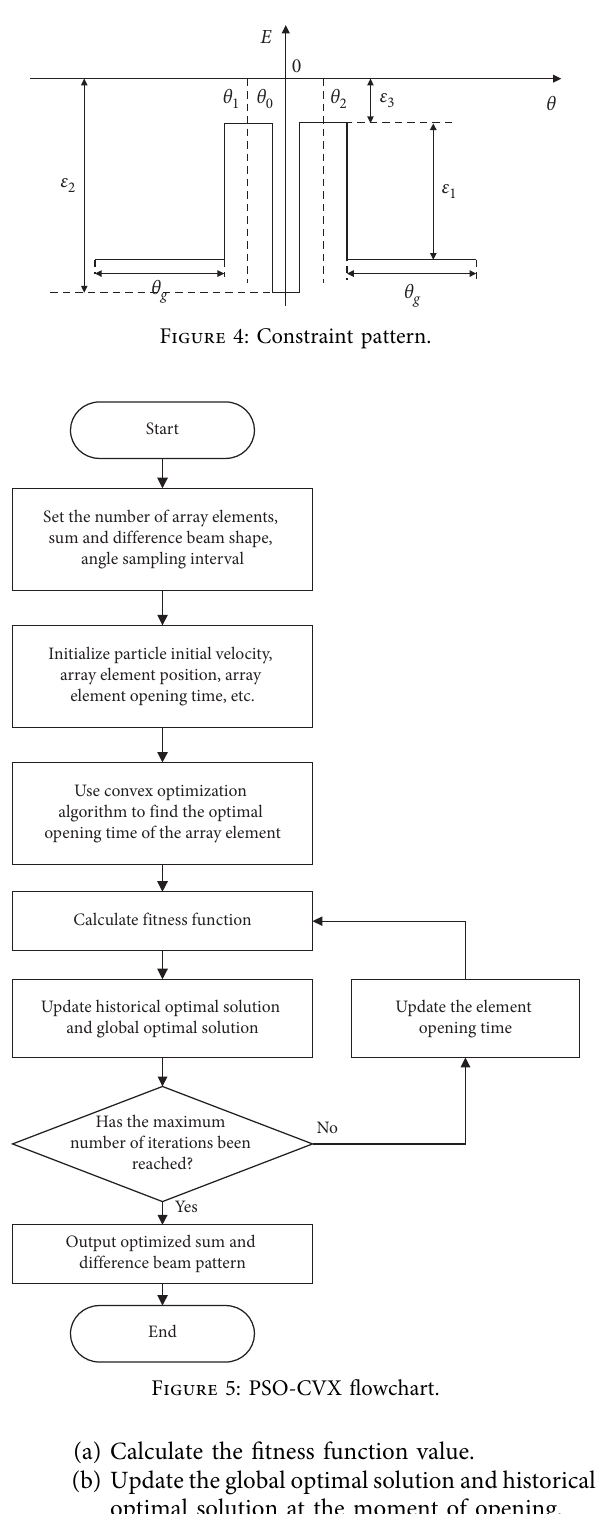
Figure 5: PSO-CVX